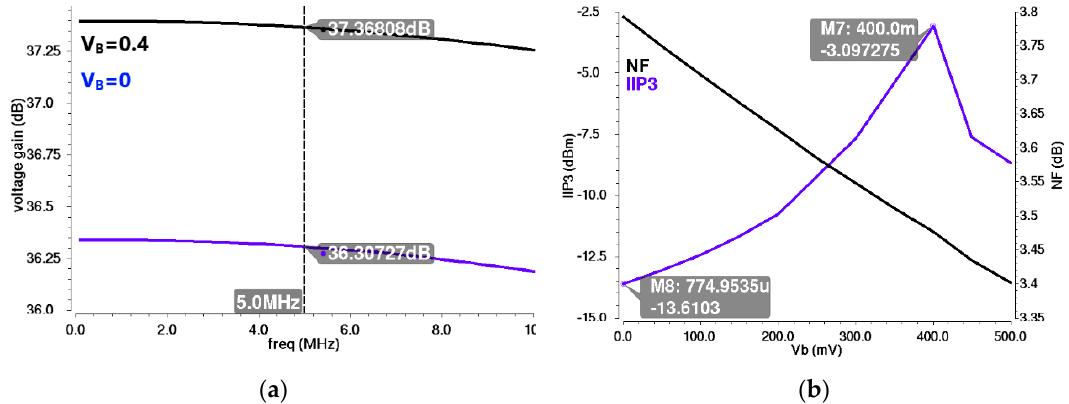
3 g ms / g sw and K 2 g ms / g sw .